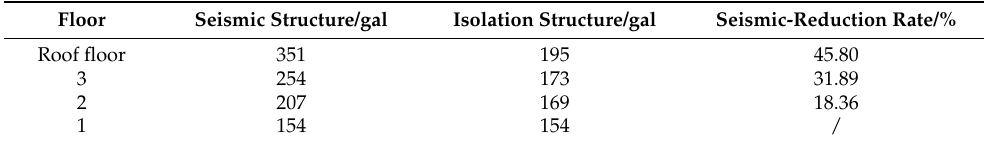
Table 5. Structural acceleration and seismic-reduction